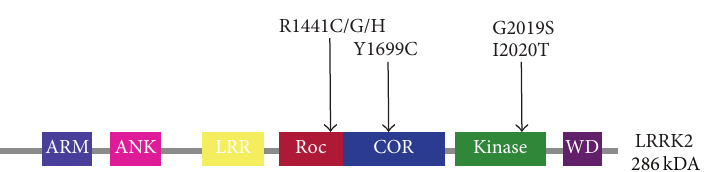
Figure 1: Schematic diagram of the domain architecture of LRRK2. Above, the segregating mutations of LRRK2 in Parkinson’s disease are shown (arrows). ARM: Armadillo repeats, ANK: Ankyrin repeats, LRR: leucine-rich repeats, and WD: WD40 repeats.